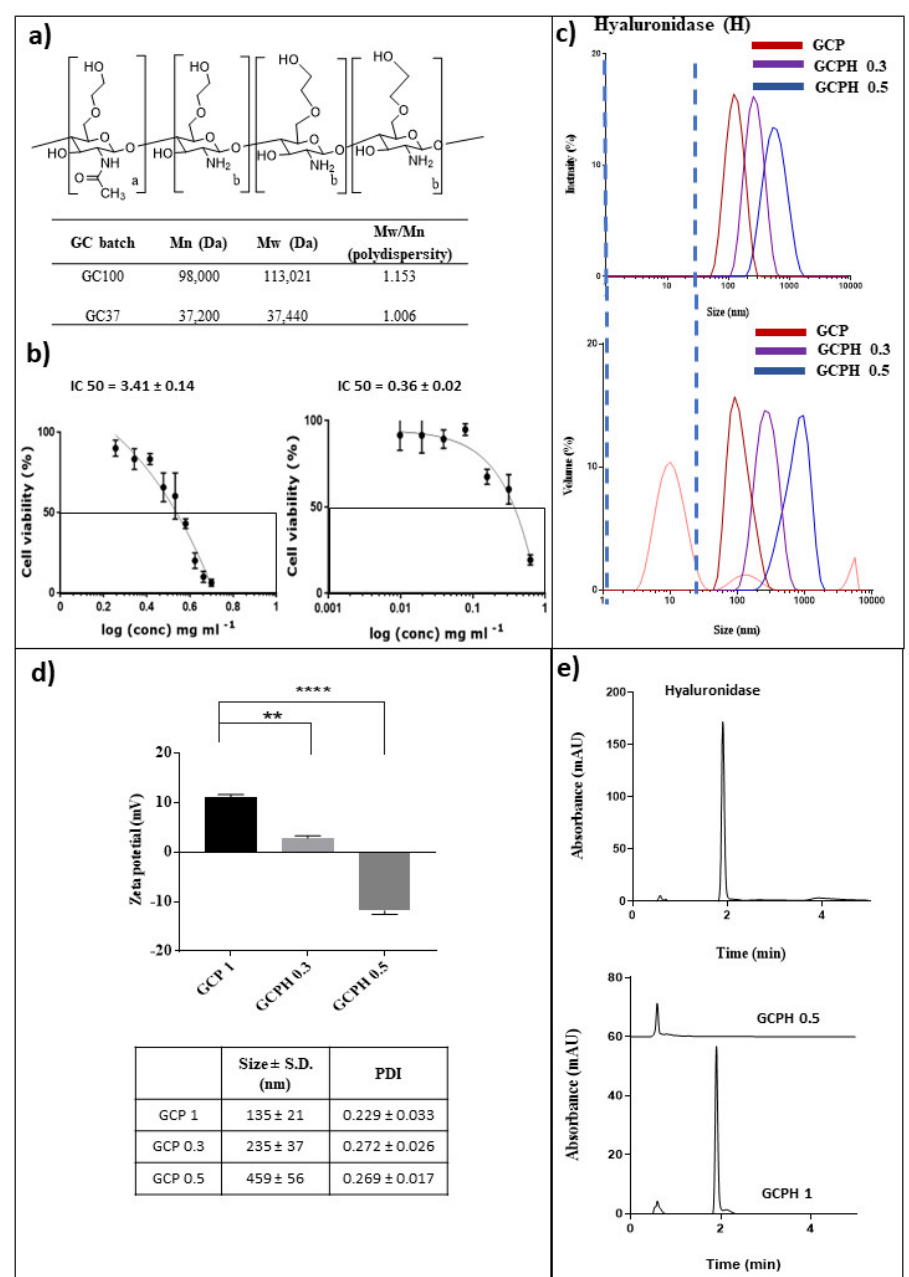
Figure 1. Structure of glycol chitosan (GC), molecular weight and PDI for degraded and non- degraded GC ( a ). IC 50 values for GC37 and Lipofectamine in U87 cells ( b ). Intensity and volume size distribution plots of GCP 1, GCPH 0.3, GCPH 0.5 and hyaluronidase ( c ). Zeta potential values, size and PDI of GCP, GCPH 0.3 and GCPH 0.5 ( d ). The zeta potential of polyplexes without HYD (GCP) is significantly different when compared to polyplexes coated with HYD (GCPH 0.2, ** p ≤ 0.01) and (GCPH 0.3, **** p ≤ 0.0001) ( d ). HPLC chromatograms of free hyaluronidase (top) and ternary complexes with 1 mg mL − 1 hyaluronidase-GCPH 1 and with 0.5 mg mL − 1 hyaluronidase-GCPH 0.5 (bottom) ( e